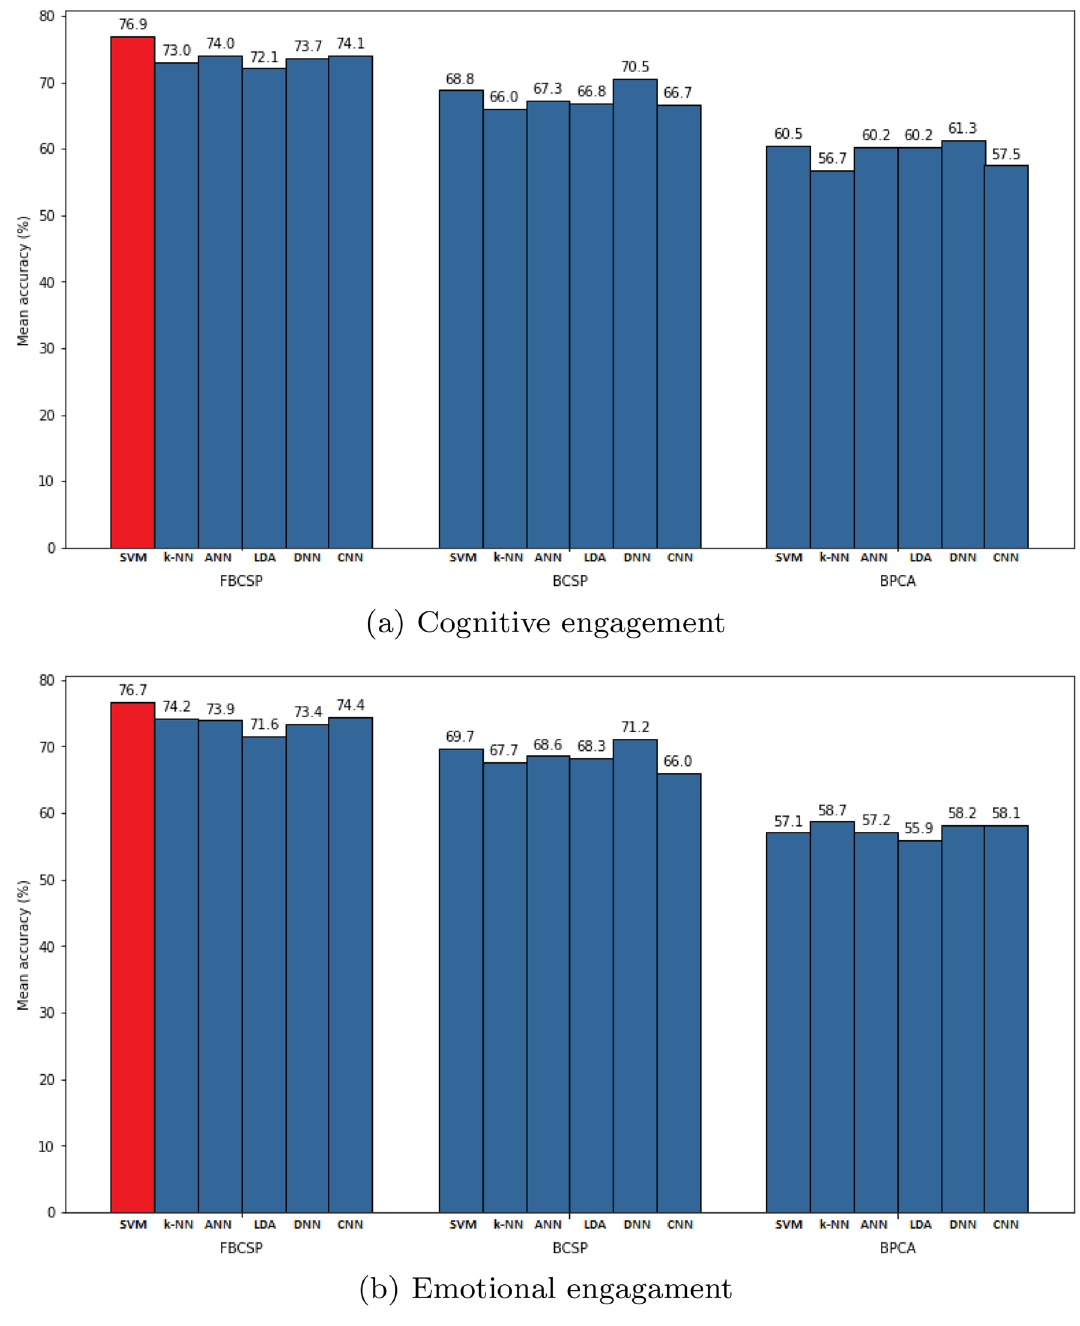
accuracy over all the